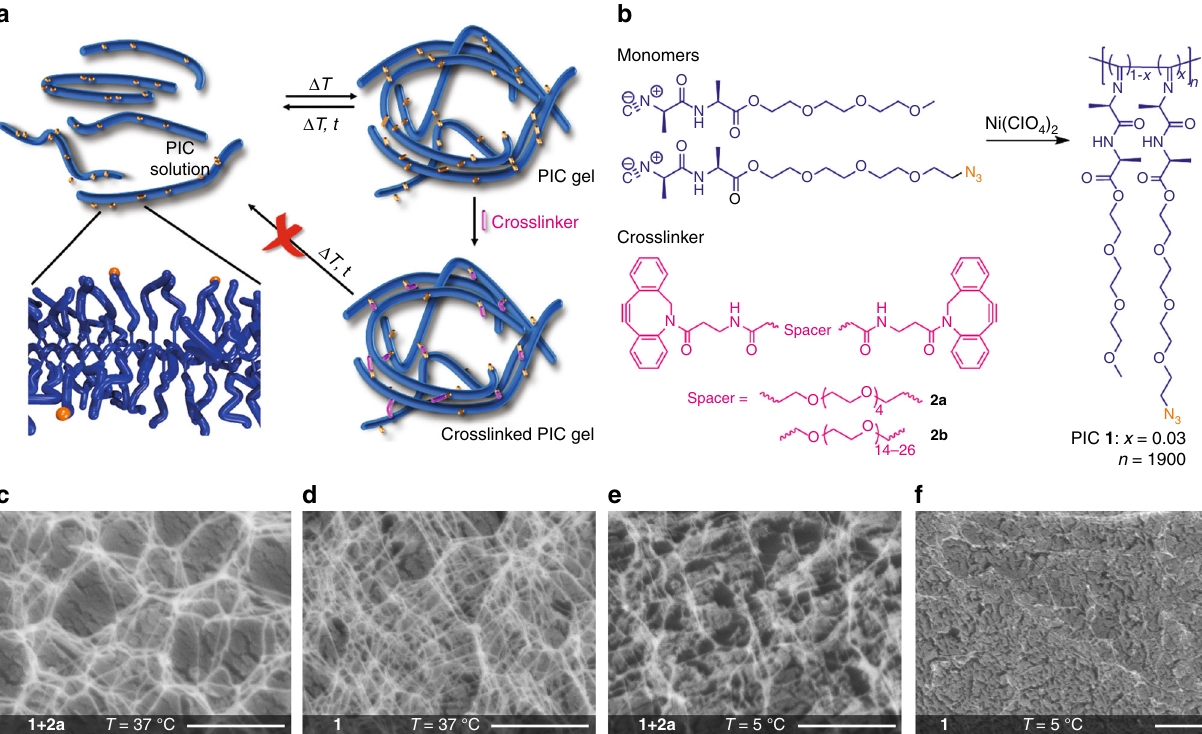
Fig. 1 Crosslinking a bundled network. a Schematic representation of the crosslinking method. Azide (orange) decorated polymers (blue) are gelled and crosslinked selectively within the bundles by a crosslinker (pink), stabilizing the architecture. b Gel components: PIC 1 (yield: 94%, 3.3-mol-% N 3 , M v = 599 kg mol − 1 ) and crosslinkers 2a and 2b . c – f Freeze-fractured cryoSEM micrographs of PIC gels (scale bars = 1 µ m): crosslinked ( c ) and not-crosslinked ( d ) gel at T = 37 °C and crosslinked ( e ) and not-crosslinked ( f ) gel at T = 5 °C. Note that in the fi nal cryoSEM image, the network structure has